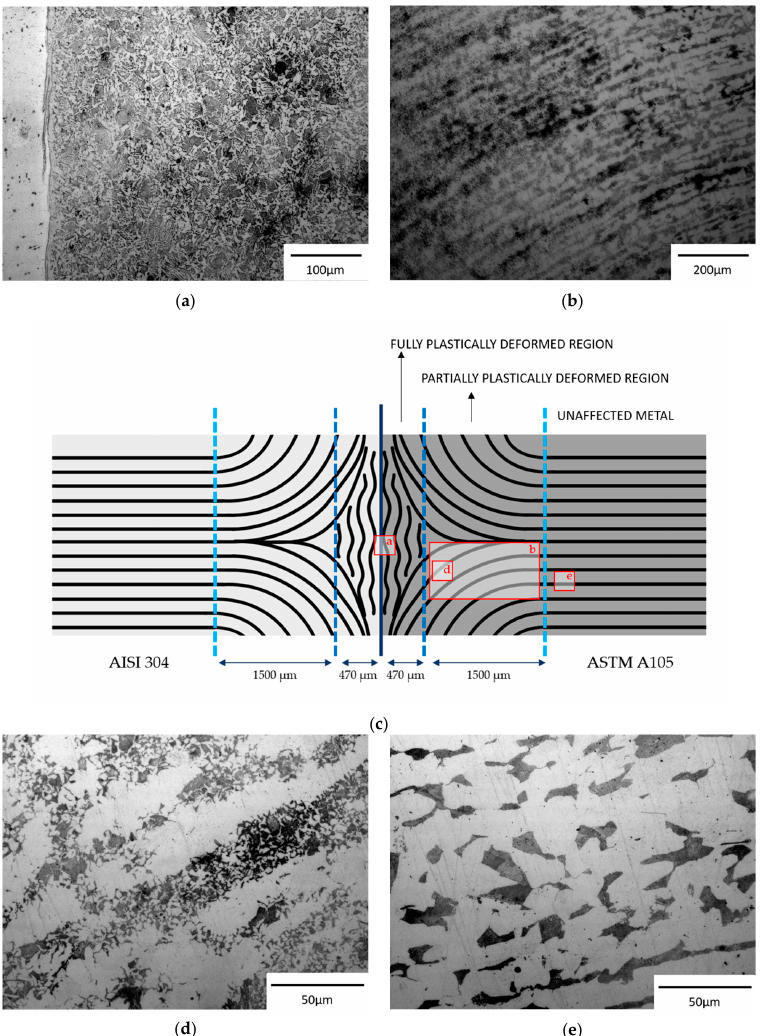
Figure 4. Optical images of the welded sample microstructures. ( a ) Interface region (AISI 304 on the left side and ASTM A105 on the right side of the interface); ( b ) intermediate region; ( c ) schematic representation of the sample; ( d ) intermediate region at high magnification; ( e ) base metal.